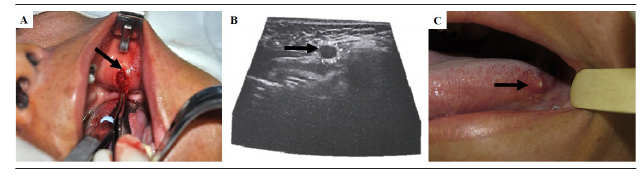
FIGURE 1 – Clinic aspects of oral lymphoid hyperplasia A) surgical excision of nodular lesion on the left buccal mucosa; B) ultrasonography showed radiolucent image of a nodular solid, well-defined, hypoechoic with echogenic halo and texture, poorly vascularized with well-defined margins; C) clinical evidence of lymphoid hyperplasia on the left lateral border of the tongue, showing a lesion of small dimensions (0.8 cm), nodular and yellowish